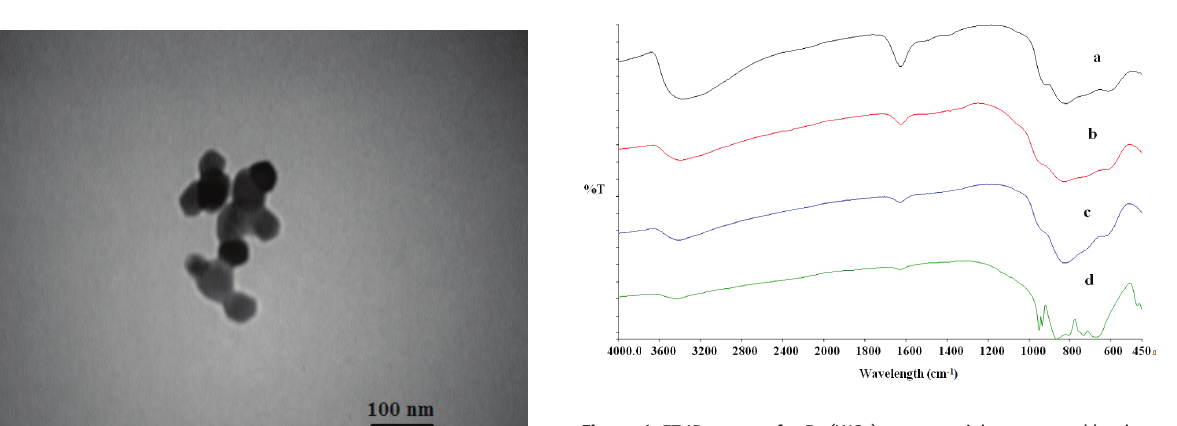
Figure 6: FT-IR spectra for Pr precipitation reaction at optimum conditions (a) before annealing, (b) aft er annealing at 200 °C, (c) aft er annealing at 450 °C, and (d) aft er annealing at 650 °C